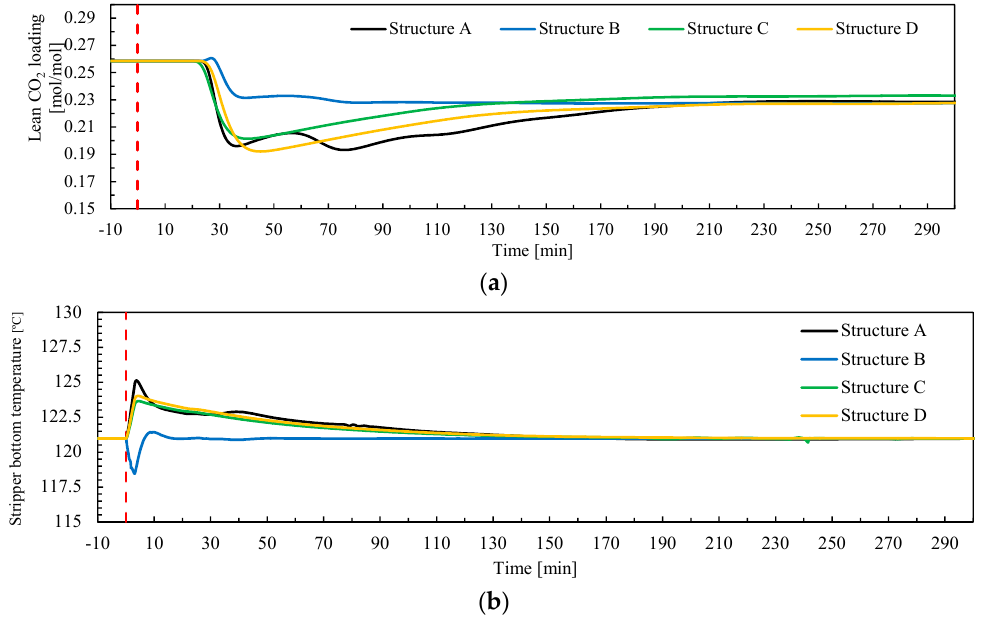
Figure 11. Outputs from pilot plant model during simulations for load change ramp-down (Test 1) from 100 to 70% with a ramp rate of 10%/min reduction in flue gas flow rate, for control structures A, B, C and D. ( a ) Lean CO 2 loading at the inlet of the absorber; ( b ) Stripper bottom temperature as controlled variable (°C). The red vertical dotted line shows when the transient event starts at t 0 .